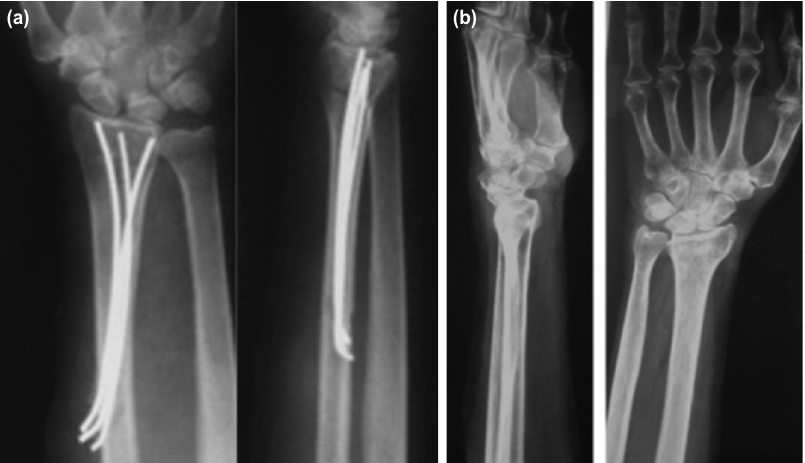
(a) Radiographic images showing union at the final follow-up with wires in-situ, and (b) following removal of wires. Fig. 4: